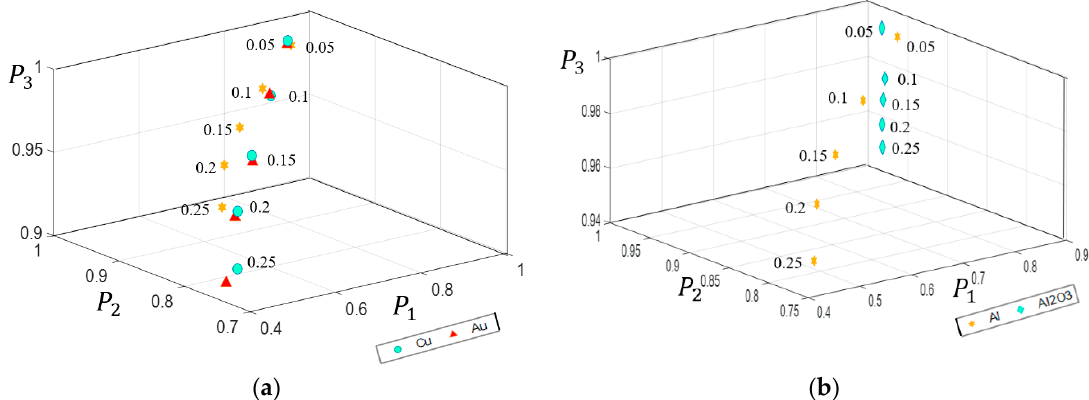
Figure 5. The overall distributions of P 1 , P 2 , P 3 corresponding to different roughnesses ( a ) samples as Cu, Au, Al; ( b ) samples as Al, Al 2 O 3.